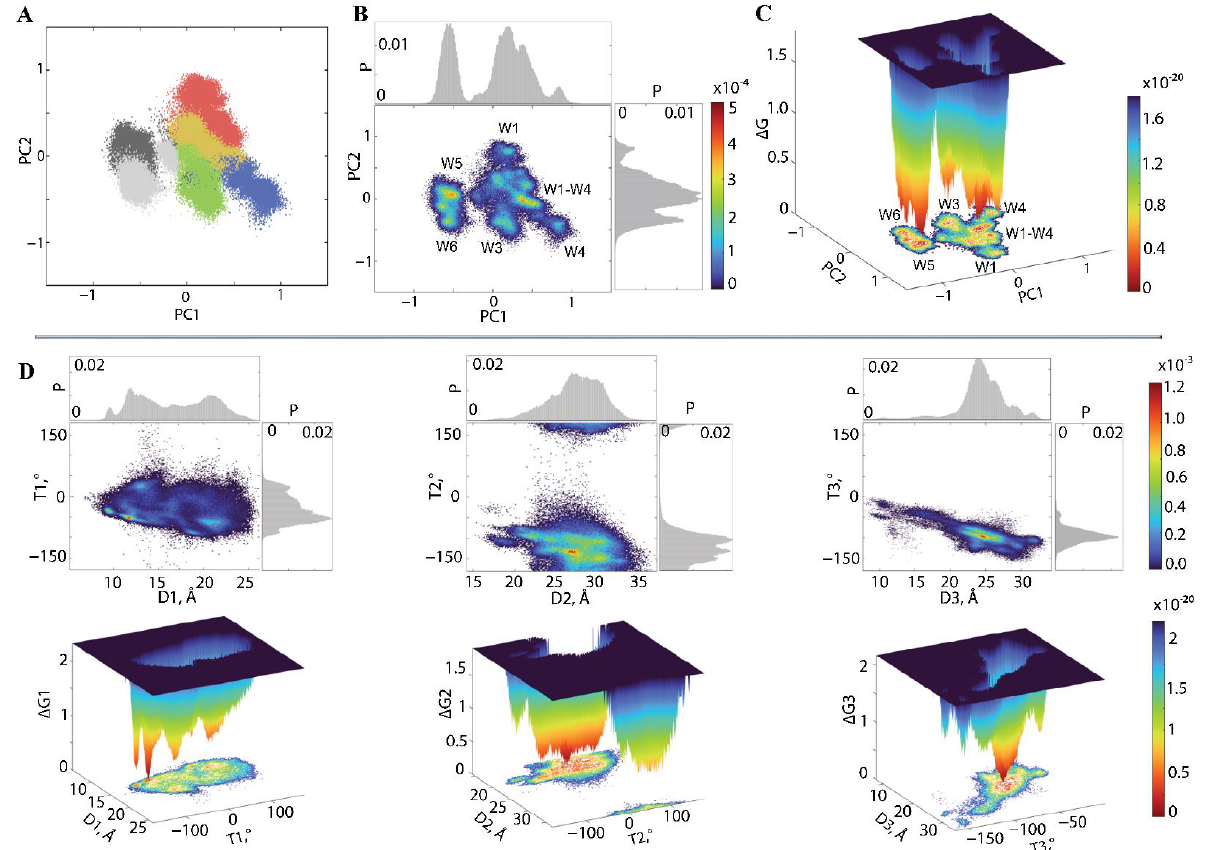
Figure 8. Free energy landscape (FEL) of KID in the 2- and 3-dimensional representations as a function of the reaction coordinates. ( A ) Projection of KID conformations on two principal components, PC1 and PC2. Clusters are coloured as in Figure 7C: C1 in red, C2 in yellow, C3 in green, C4 in blue, C5 in dark grey, and C6 in light grey. ( B , C ) FEL of KID defined on PC1 and PC2 as the reaction coordinates. ( D ) FELs of KID determined by using as the reaction coordinates the most fluctuating metrics in KID—pseudo-torsion (dihedral) angles T1 (K725-E699-Y703-S717), T2 (R739-E699-Y703-K725), and T3 (R739-E699-Y703-S717) and the respective distances D1–D3 between two highly fluctuating atoms. FELs were generated on the 14 µ s concatenated trajectory composed of MD conformations of all KID entities studied—KID C , KID D , and KID GC . Blue represents the high energy state, green and yellow low and red represents the lowest stable state. The free energy surface was plotted using Matlab.